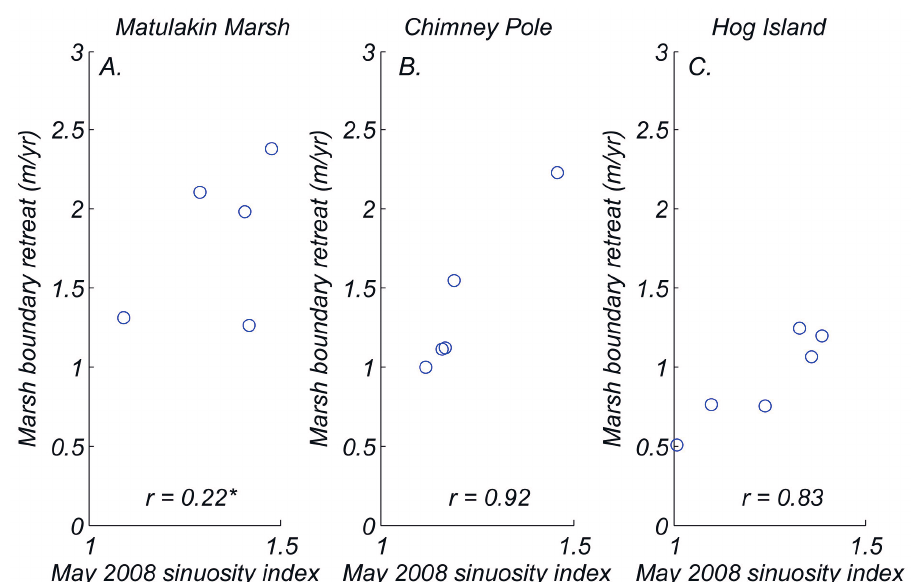
Figure 8. Marsh edge erosion rate as a function of shoreline sinuosity. Each data point represents the average erosion rate and sinuosity within each boundary section (see Figure 3) between May 2008 and April 2010. Sinuosity is used as a proxy for the presence of wave-cut gullies, whereby erosion is more vigorous due to concentration of wave